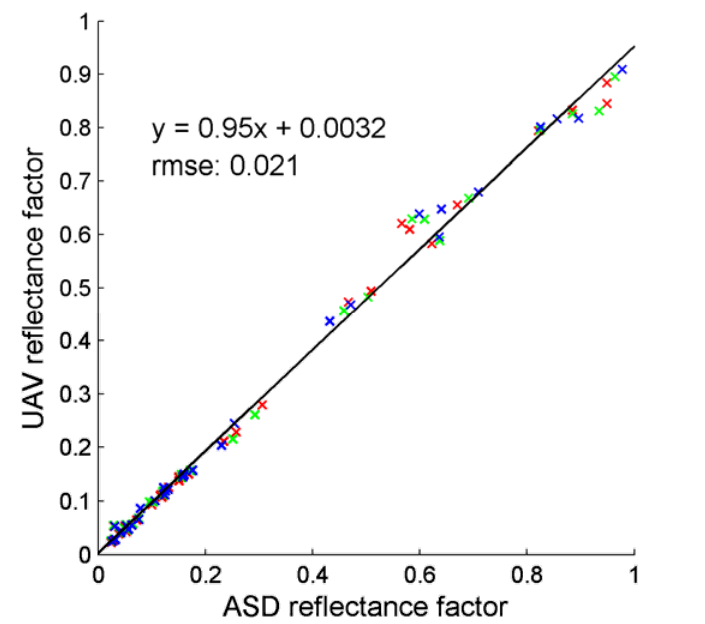
Figure 7. A scatter plot of the validation measurement data. X axis: Ground reflectance factor data measured with ASD Field SpecPro from estimated red, green and blue channels. Y axis: Reflectance factor values extracted from the UAV image from the same targets and color channel as the ASD data. Red, green and blue crosses refer to the respective channel. A line is fitted to the data, and a clear linear relationship can be seen. Color targets 3, 5, 6, 7, 9, 17, and 22 (in Figure 6) were not used due to the unknown camera spectral